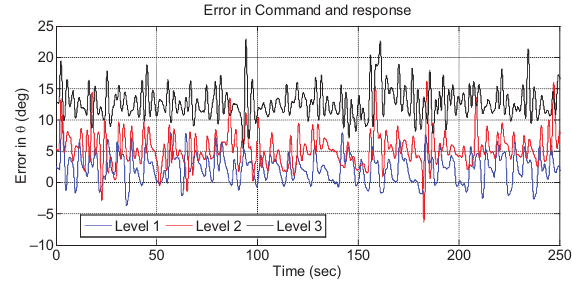
Figure 8. Error in pitch angle for different HQ levels